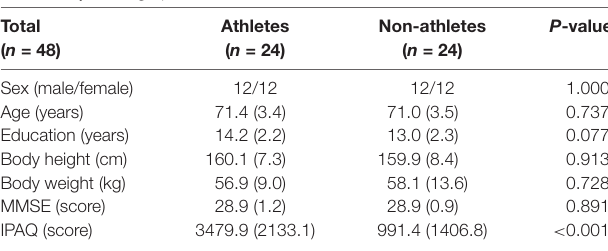
TABLE 1 | Demographics of athletes and non-athletes.